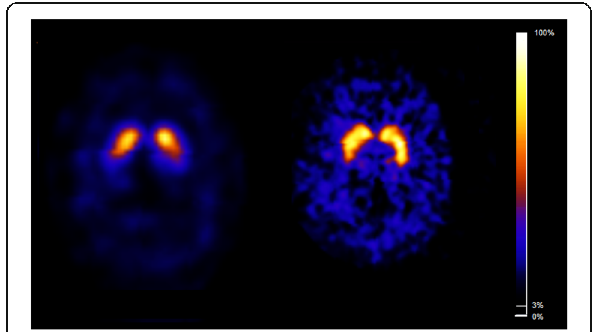
Fig. 2 Discordant visual rating between both systems. Tranversal images of the [ 123 I]FP-CIT SPECT scans rated visually as abnormal (PD-like; due to relatively low binding in the left putamen vs left caudate nucleus) on the NeuroFocus (left panel) and as “ normal ” on the InSPira (right panel) obtained in subject #8. Images are displayed in radiological orientation (left is